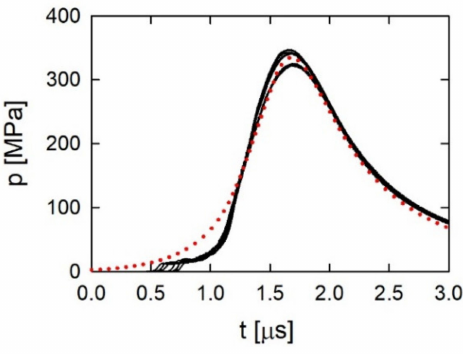
Figure 12. Measured (solid line) and calculated (dotted line) pressure courses in 12.7 mm